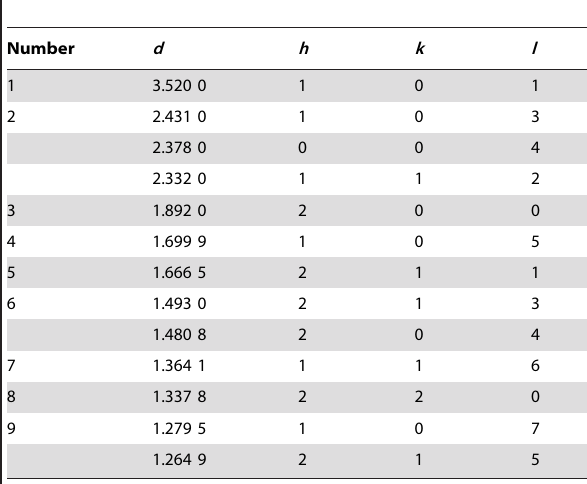
Table 2. The Diffraction Rings Indexed according to JCPDS, card No: 21–1272.